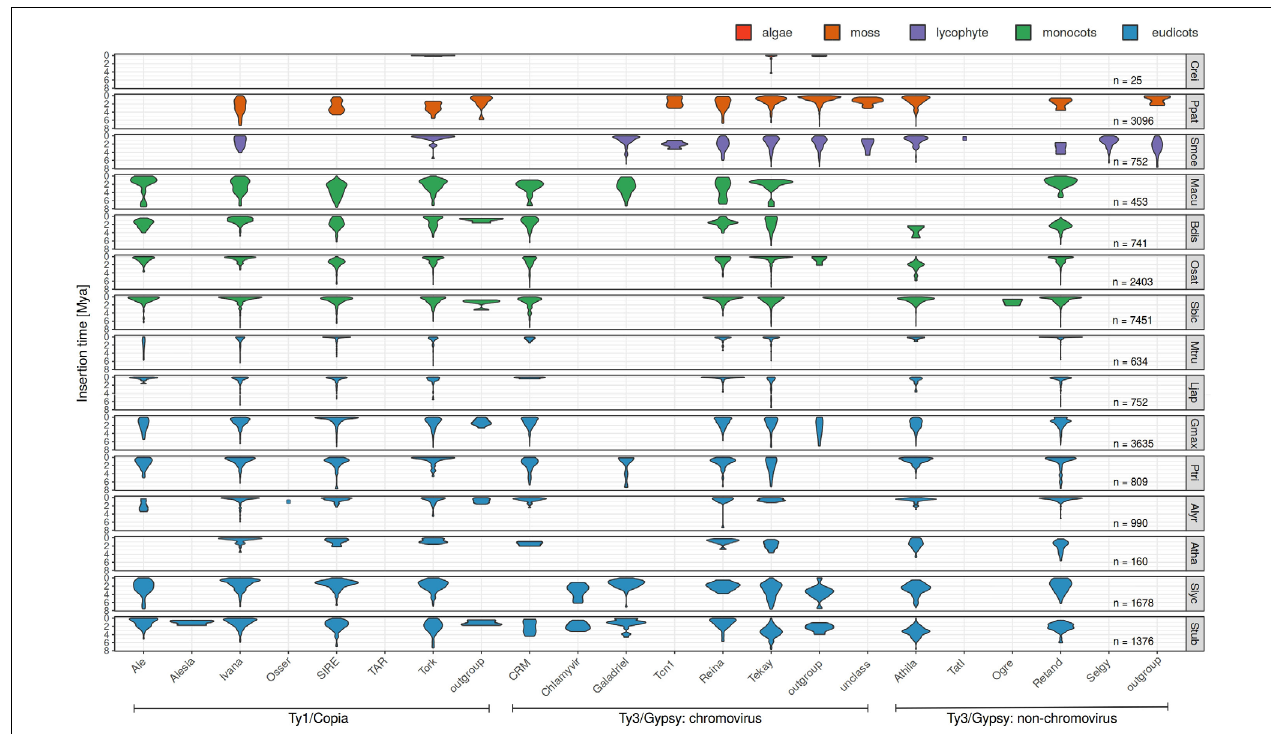
FIGURE 1 | Evolutionary dynamics of LTR retrotransposons of fifteen plant species using LTR divergence method for LTR retrotransposon age estimation. For each species and each family, we measured the abundance of elements having specific LTR divergence to reveal evolutionary expansions and contractions occurring within each family. Nested, original and non-nested LTR retrotransposons were analyzed